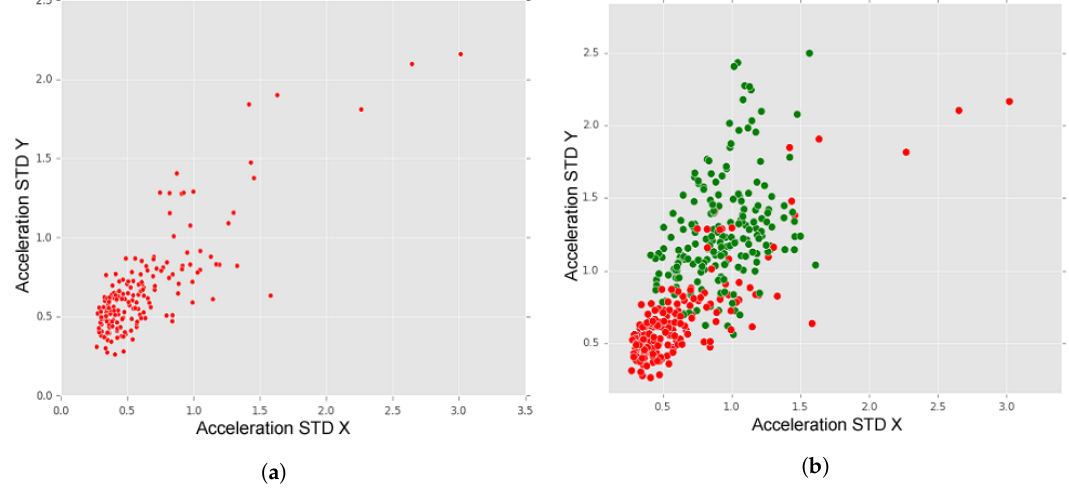
Figure 10. ( a ) No anomaly; and ( b ) no anomaly (red dots) and anomalies (green